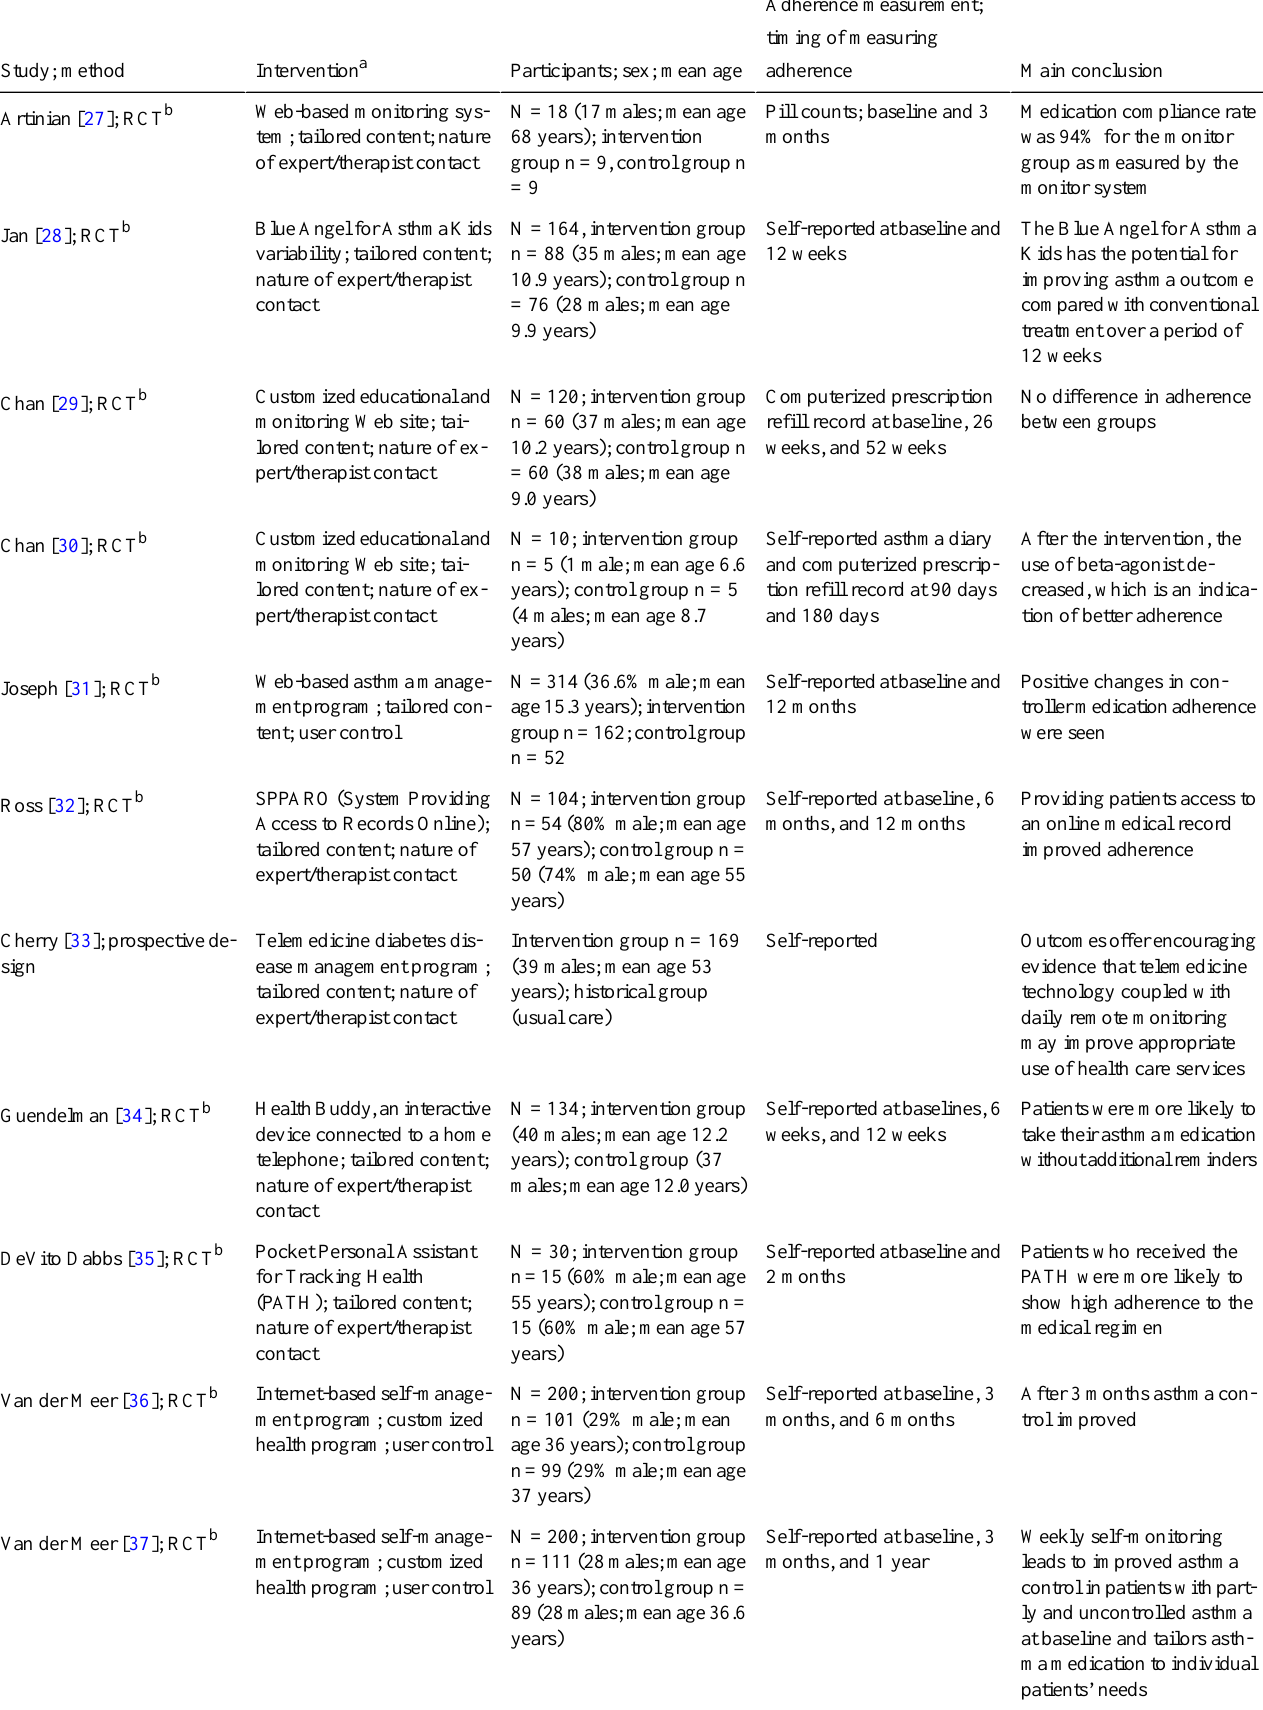
Table 2. Characteristics of included